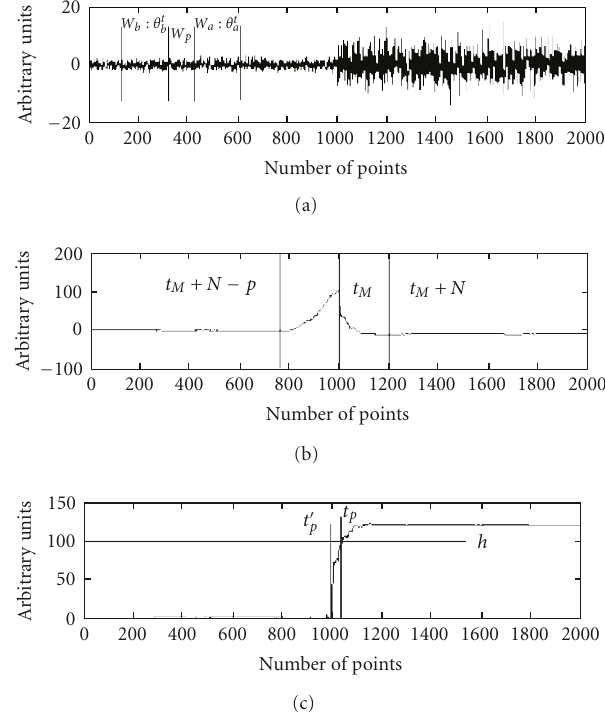
Figure 2: Upper tracing: position of the estimation and prediction windows. Middle tracing: evolution of DCS around the change time t M . Lower tracing: detection function. For all tracings, x -axis: num- ber of points, y -axis: arbitrary